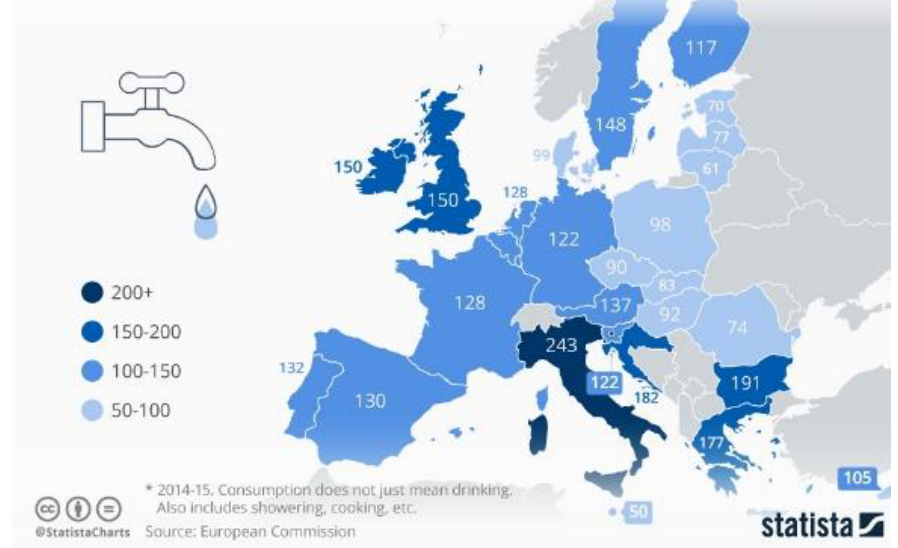
Figure A2. Average consumption of tap water per person in the EU, 2014–2015 (liters/day). Source: https://www.statista.com/chart/19591/average-consumption-of-tap-water-per-person-in-the-eu/ (accessed on 19 June 2021).